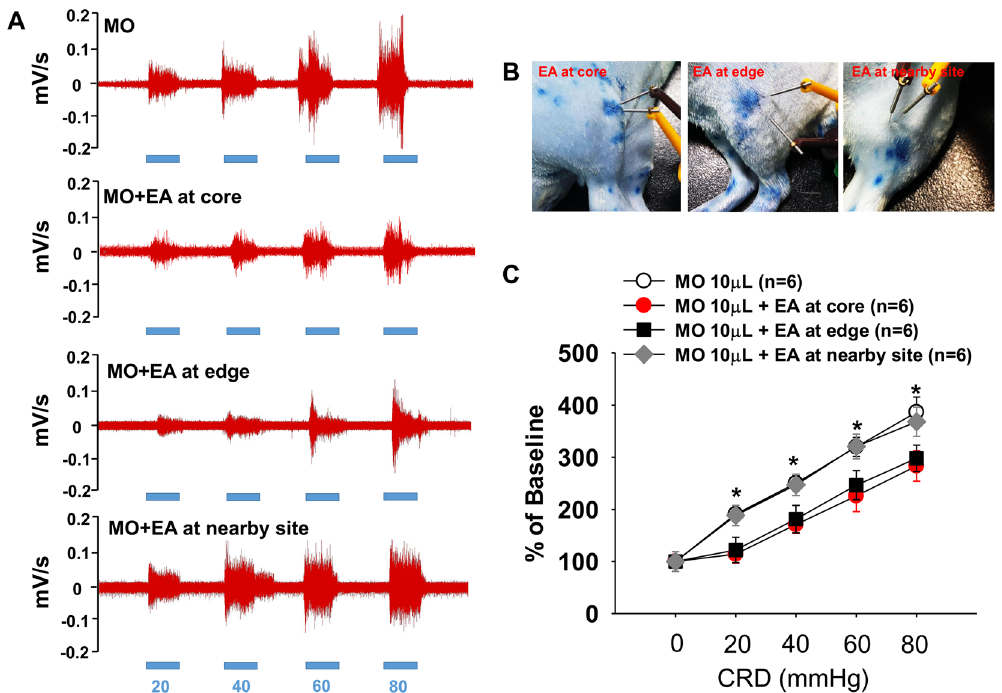
Figure 3. ( A – C ) Effect of electroacupuncture at core, edge, or site outside (nearby site) of the Neuro-Sp on EMG activities in the external oblique muscle in response to graded CRD in MO-infused rats (MO) * p < 0.05 vs. MO. Representative EMG signals ( A ) and pictures for EA at core, edge or nearby site of Neuro-Sp ( B